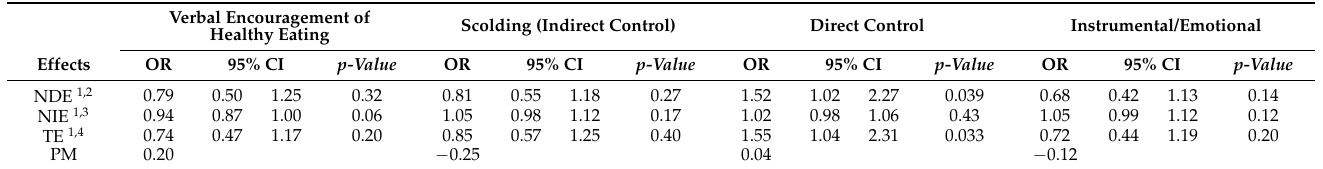
Table 3. Mediation of TCRAD score in the association between PFS scores and the odds of excess weight in Costa Rican adolescents ( n =